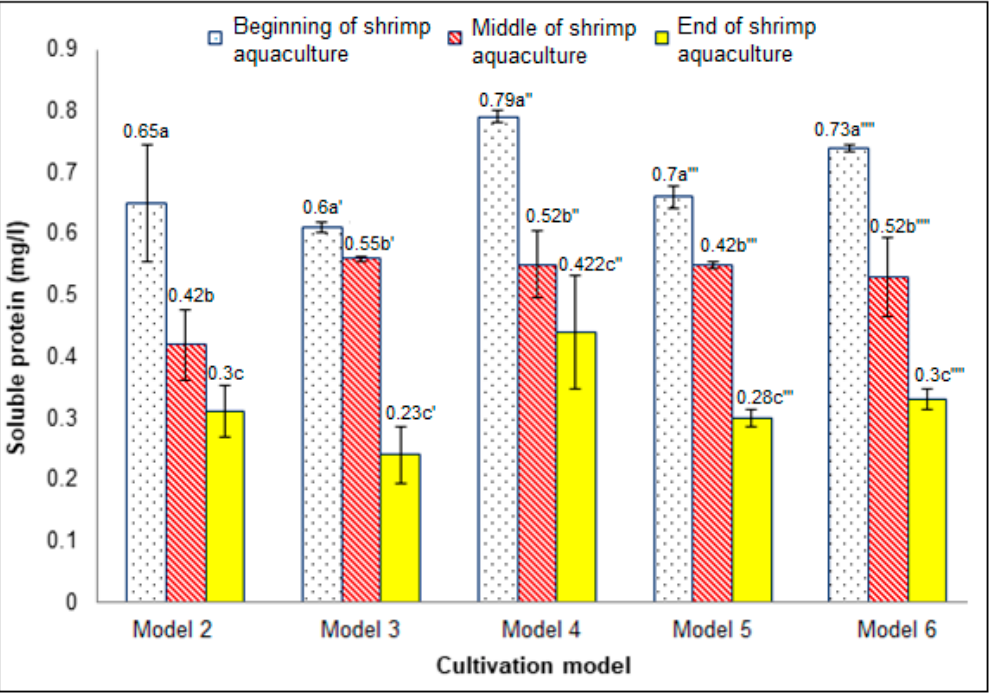
Figure 4. Variations of soluble nitrogen in farming models. Notes: a and b are compared according to sampling time, the same letters within the same column or row have no significant difference. The symbols ’, ’’, ’’’, ’’’’ are used to distinguish different experimental or model areas. ns: no difference (compared at a significance level of 5%).